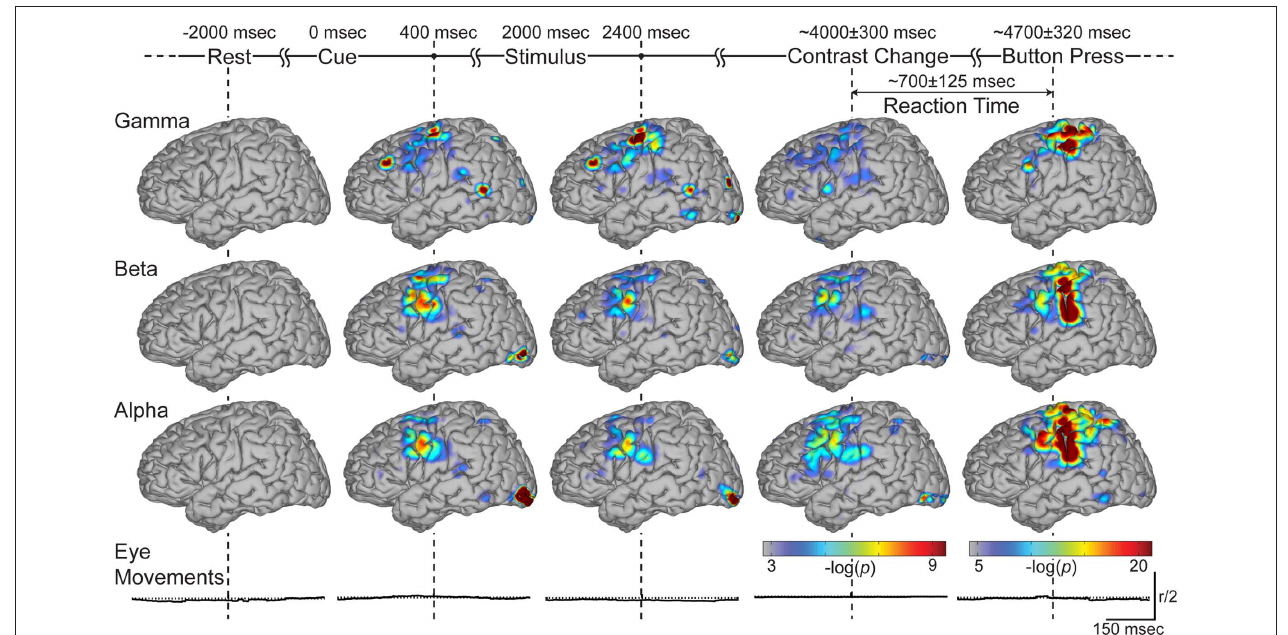
dashed lines). Note that the rightmost column, corresponding to the time around the button press, has a separate color. Bottom row depicts the radial deviation of eye gaze from the fixation cross around the significant time stamps. The vertical scale represents half the magnitude of the